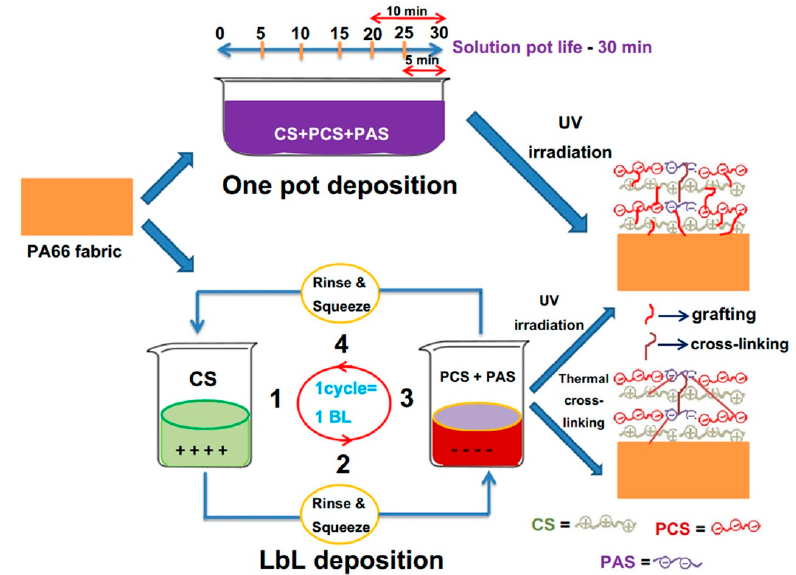
Figure 16. Scheme of the LbL vs. “one pot” deposition on polyamide 66 fabrics. CS = chitosan, PCS = phosphorylated chitosan, PAS = polyacrylate sodium, PA66 = polyamide 66. Reprinted with permission from [47]. Copyright 2020, Elsevier. Table 2. Results from cone calorimetry